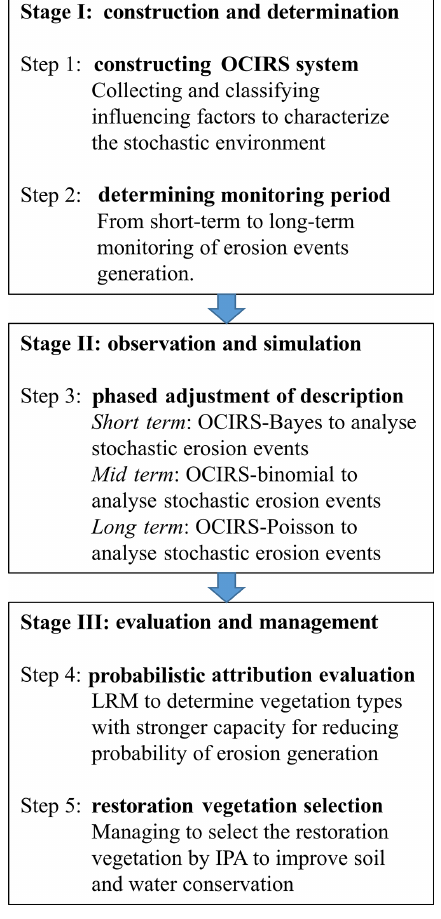
Figure 8. The framework of integrated probabilistic assessment for soil erosion monitoring and restoration